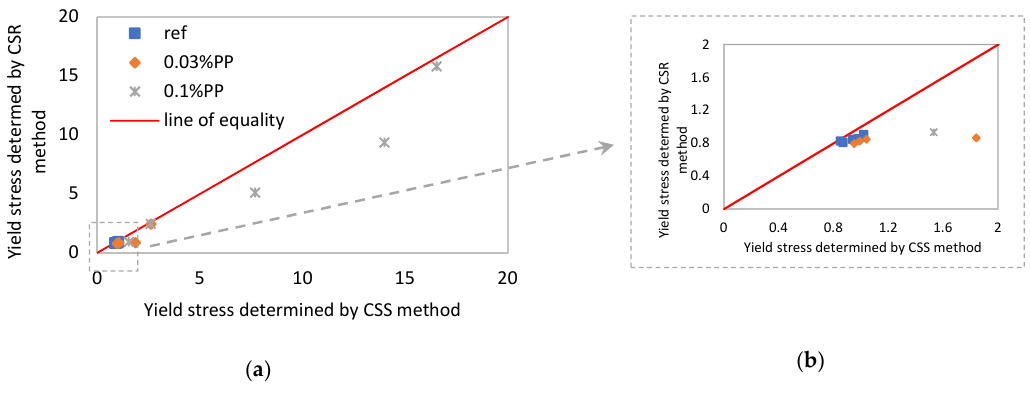
Figure 8. Comparison of static yield stress modeled by CSS and CSR: ( a ) all yield stress range; ( b ) focus on lower yield stress values.